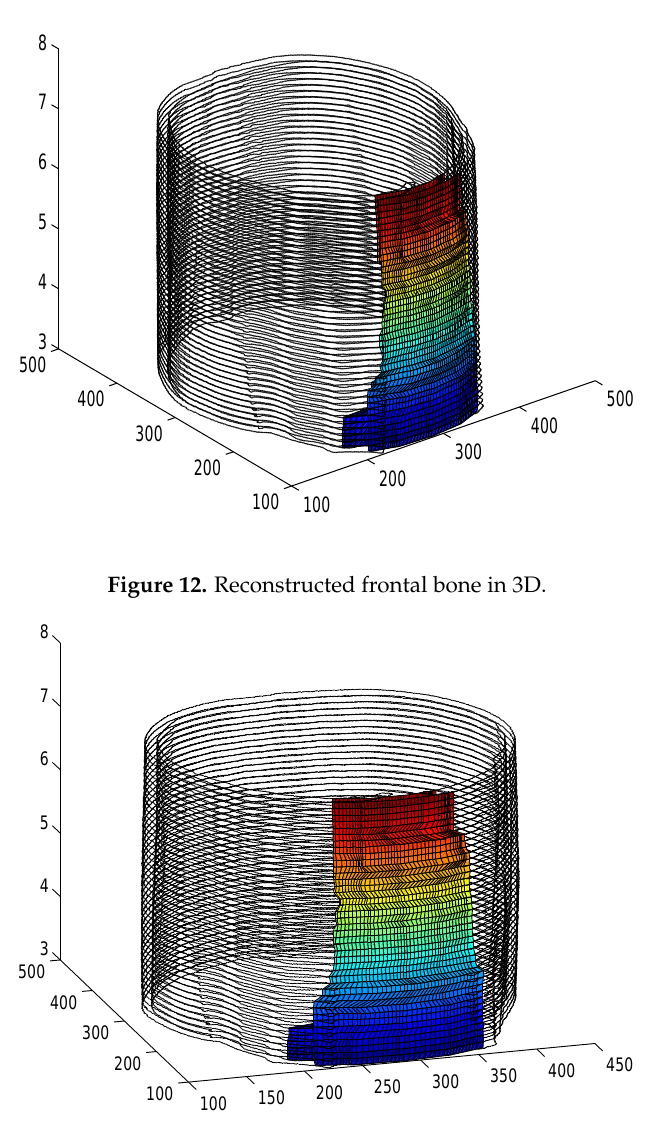
Figure 13. Reconstructed frontal bone in 3D.